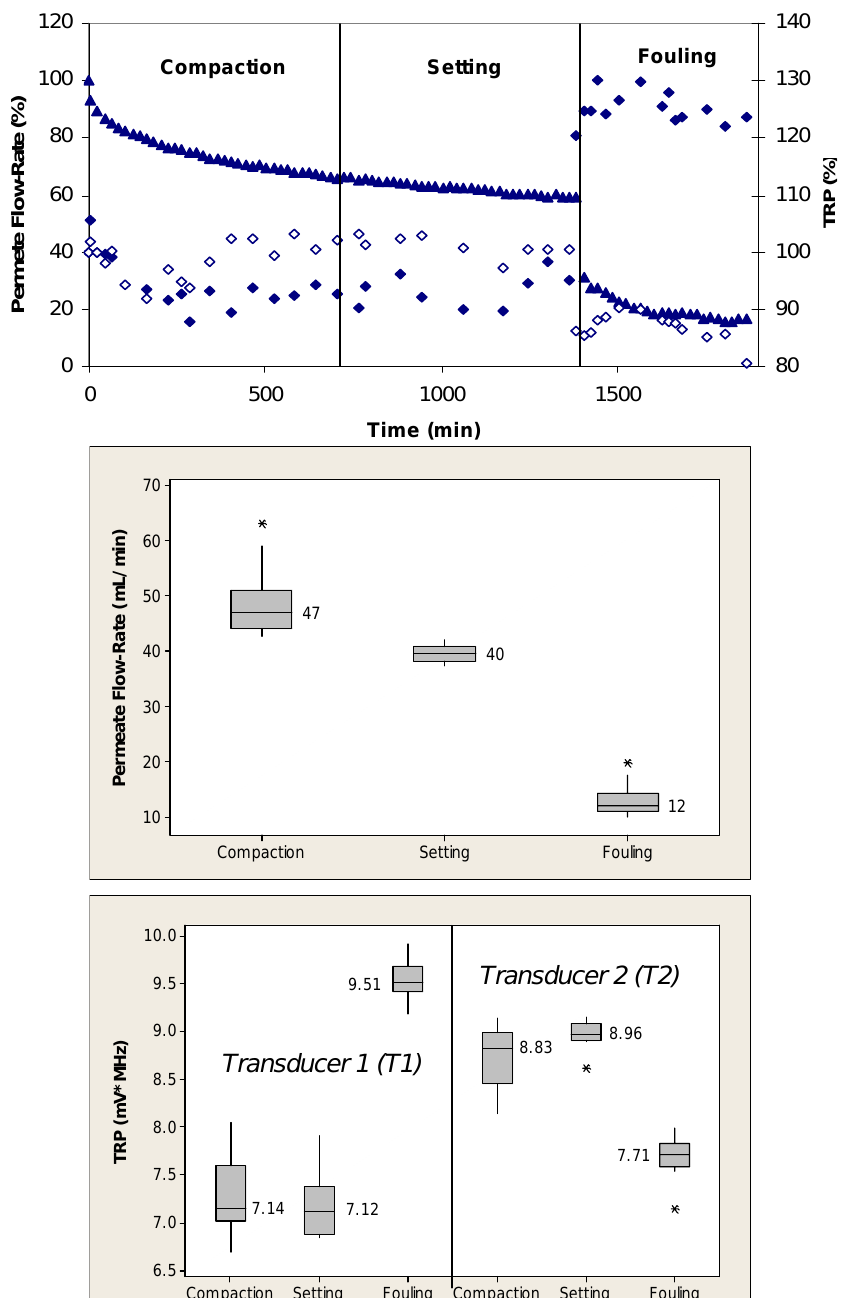
Figure 5. TOP: Permeate flow ( ▲ ) and total reflected power (TRP) from two transducers ( ♦ , ◊ ) associated with compaction, setting and fouling when PS membranes were challenged with 0.1 g/L amylase; maximum standard deviations from at least three independent observations are 5% and 19% for permeate flow and TRP, respectively. MIDDLE: Permeate flow data during the challenge represented in a box plot format where the vertical lines on the boxes indicate minimum and maximum observations; upper and lower quartiles are represented by the box boundaries and the median value is represented by the central intersecting line. BOTTOM: TRP distributions from each of two transducers mounted on the flow cells during the challenge represented in a box plot